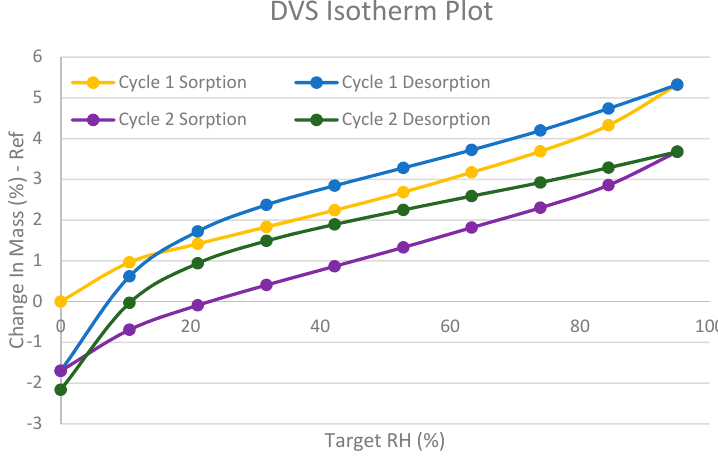
Figure 9. Esomeprazole magnesium water/1-butanol adsorption of water at increasing humidity followed by desorption at decreasing humidity. The cycle is repeated to give two